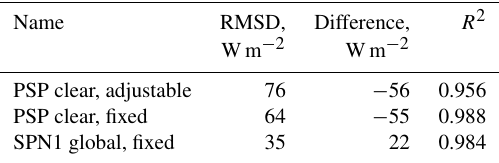
Table 1. Radiometer measurement differences shown in Fig.